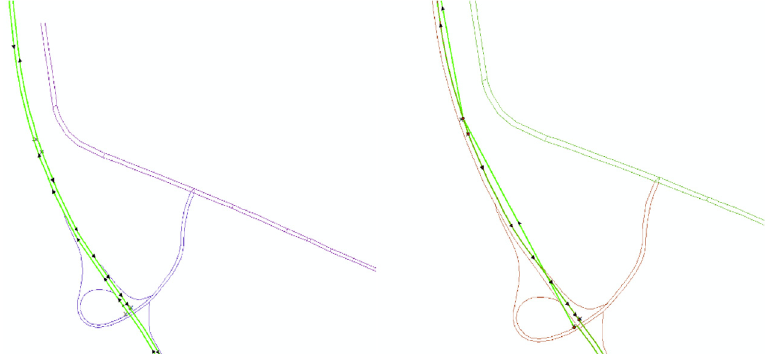
Figure 5. Matching results